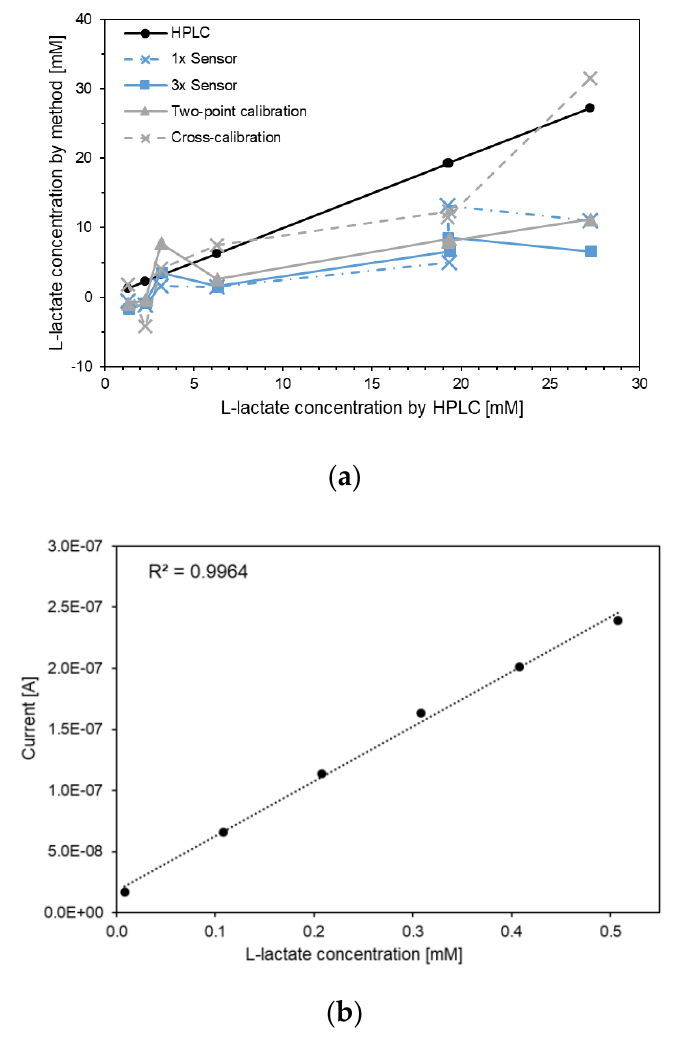
Figure 6. ( a ) The correlation of the different calibration methods with the HPLC measurements. The lactate measurements of the HPLC have been compared with the measurements of single and multiple use of the biosensors, two-point calibration and cross-calibration. ( b ) Five-point calibration in the industrial medium.